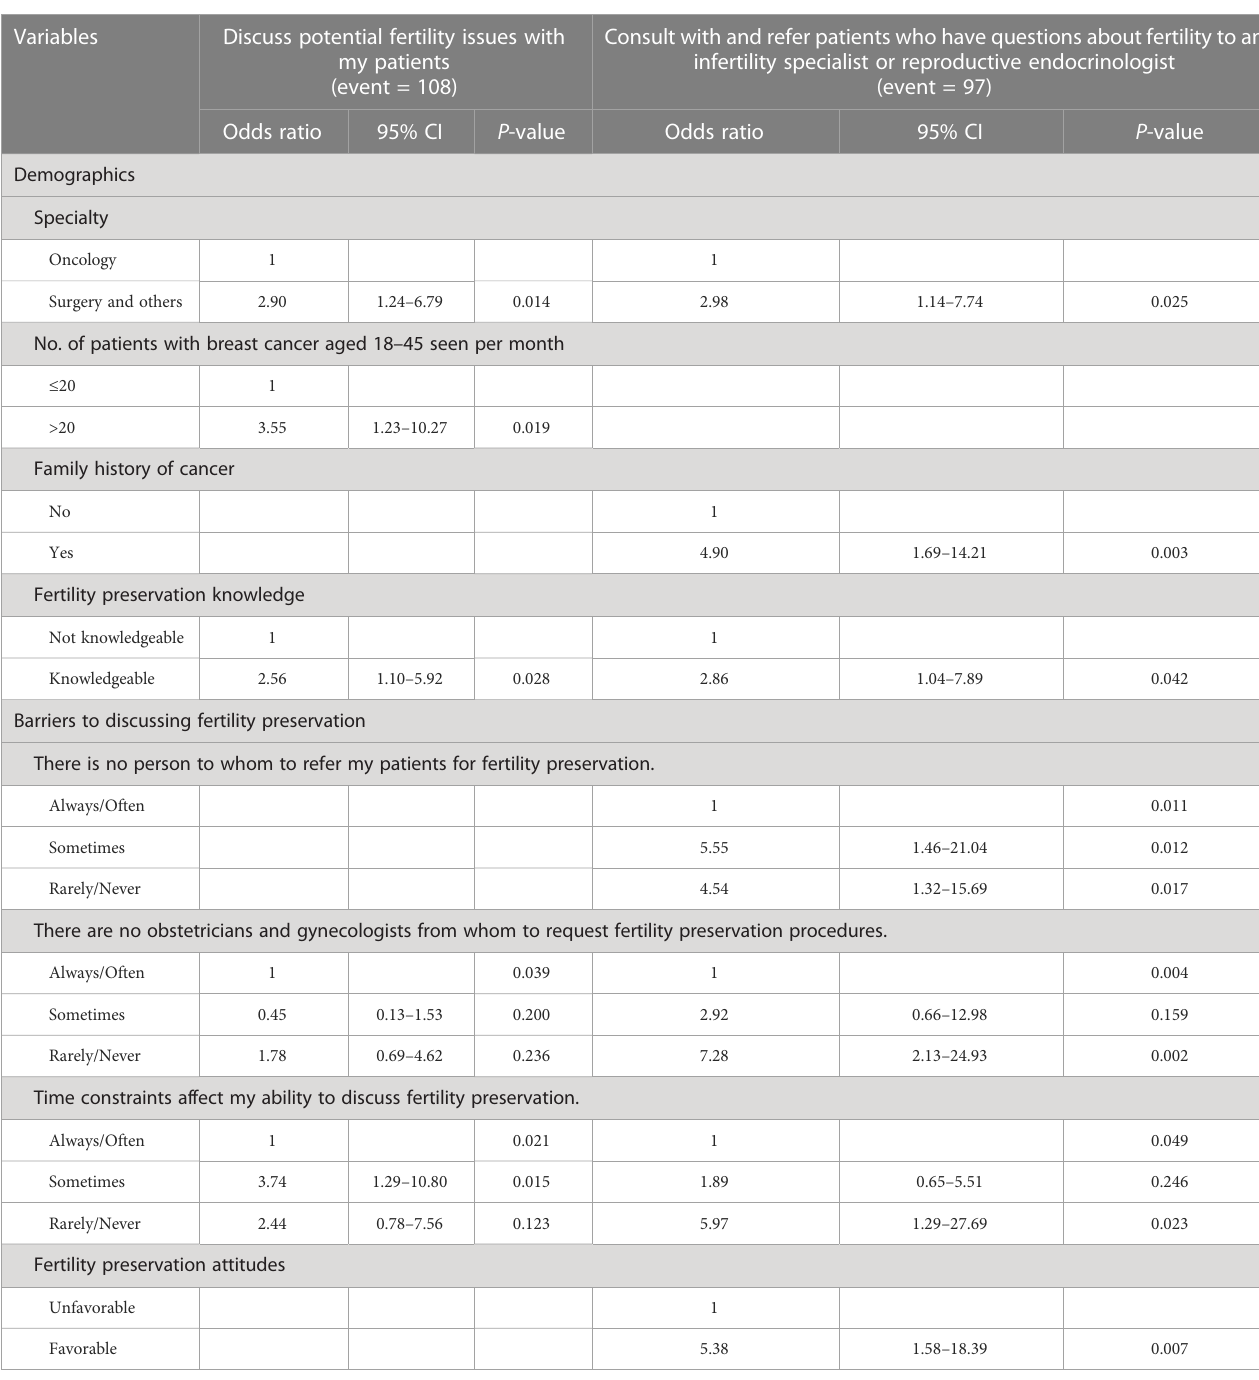
TABLE 3 Factors associated with discussion with patients and consultation and referral to